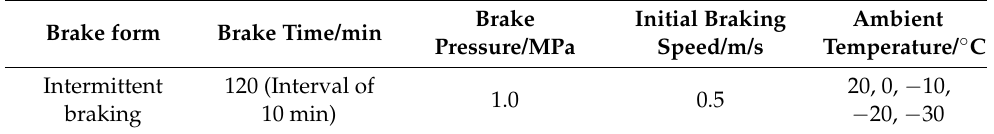
Table 2. Experimental parameter settings.